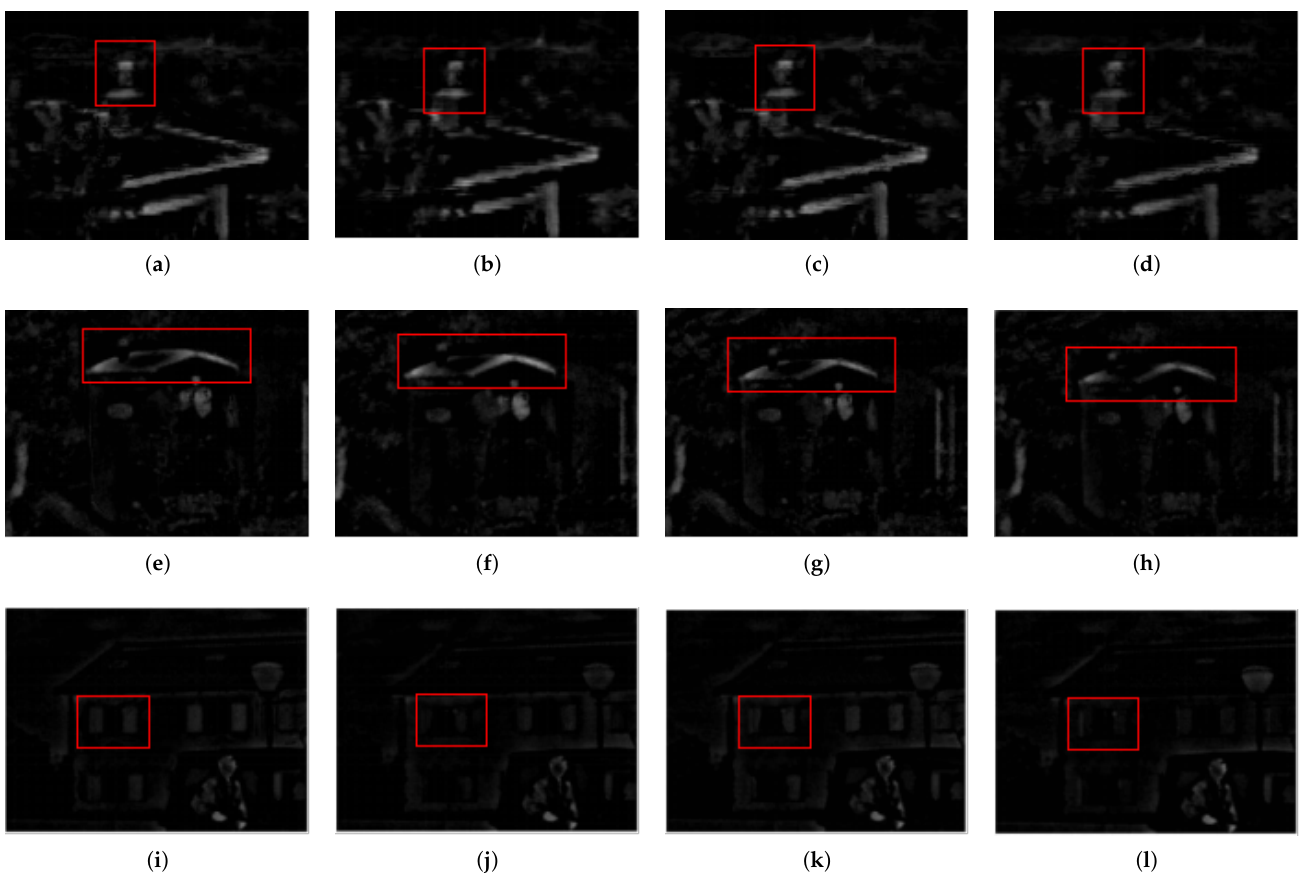
Figure 6. Fusion Comparison Graph, The red box section is the contrast area: ( a , e , i ) Proposed; ( b , f , j ) Additional fusion; ( c , g , k ) Absolute value is large; ( d , h , l ) VSM-WLS